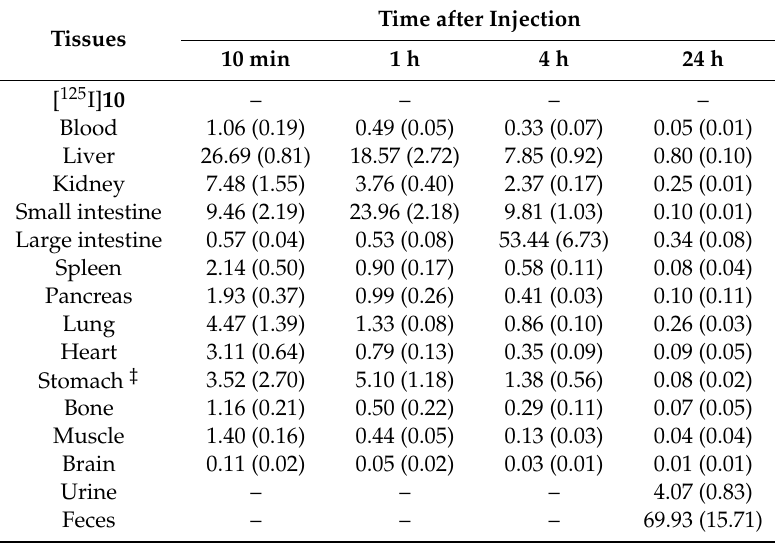
Table 3. Biodistribution of [ 125 I] 10 at 10 min, 1, 4 and 24 h after i.v. injection in ddY mice.